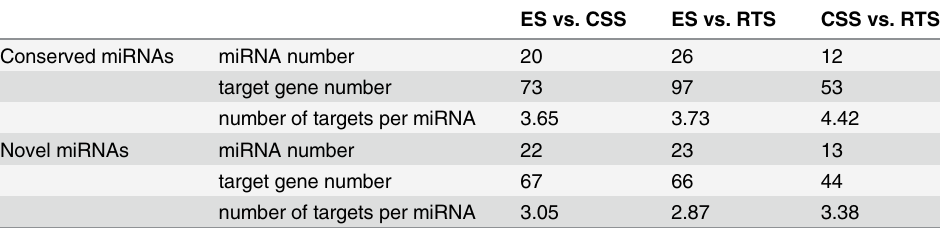
Table 4. Statistics of target genes of